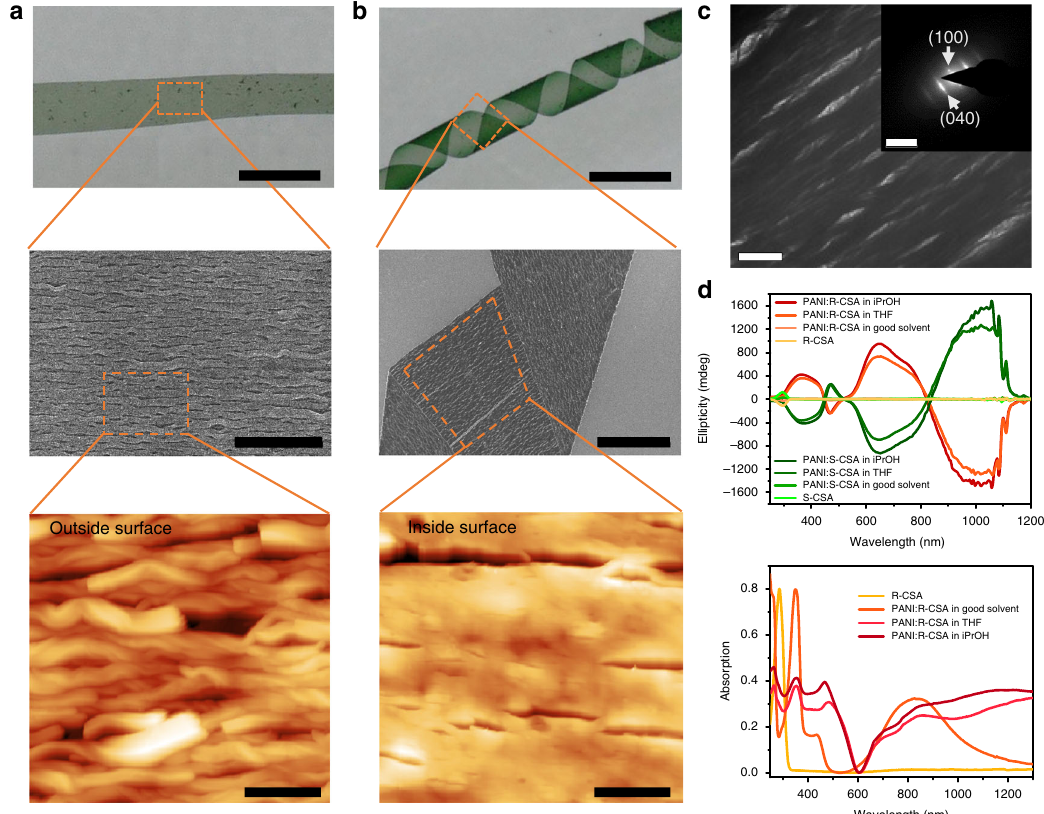
Fig. 2 Structural characteristics and basic properties of the PANI macroribbon. a Photograph of the macro stripe peeled down in THF. b Photograph of macro helical ribbon that resulted from the stripe after adding iPrOH. Scale bars corresponds 0.5 mm. SEM and AFM images show the aligned fi brous nano and micro assemblies in the stripe. As shown in the AFM images, assemblies on the outside surface of the stripe were single-handed helical ( a ) but straight on the inside surface ( b ). Scale bars of photographs in a and b correspond 0.5 mm; scale bar of SEM image in a corresponds 10 μ m, and scale bar of SEM image in b corresponds 50 μ m, respectively; scale bar of AFM images in both a and b correspond 3 μ m. c TEM image and corresponding SAED pattern of the stripe. Scale bar in TEM image corresponds 2 μ m and in SAED corresponds 5 nm − 1 . d CD and UV – vis – NIR spectra of the CSA and PANI:CSA dissolved in methanol or CHCl 3 /THF; the helical assemblies of the PANI ribbons dispersed in THF and iPrOH,